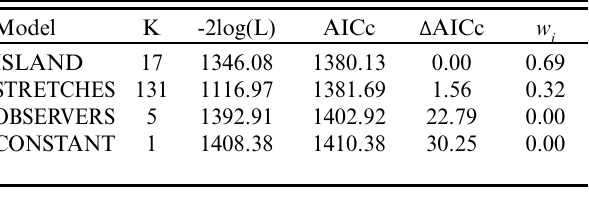
Table 3 . Candidate model set and ranking of models examining variation in the probability of detection of Blue-footed Boobies ( Sula nebouxii excisa ) during coastal surveys, June 2012. Models were evaluated with detection probabilities varying by island, varying among 30-min stretches, varying among observers, and remaining constant. The number of parameters, deviance, -2 log likelihood (-2Log(L)), small sample size-corrected AIC values